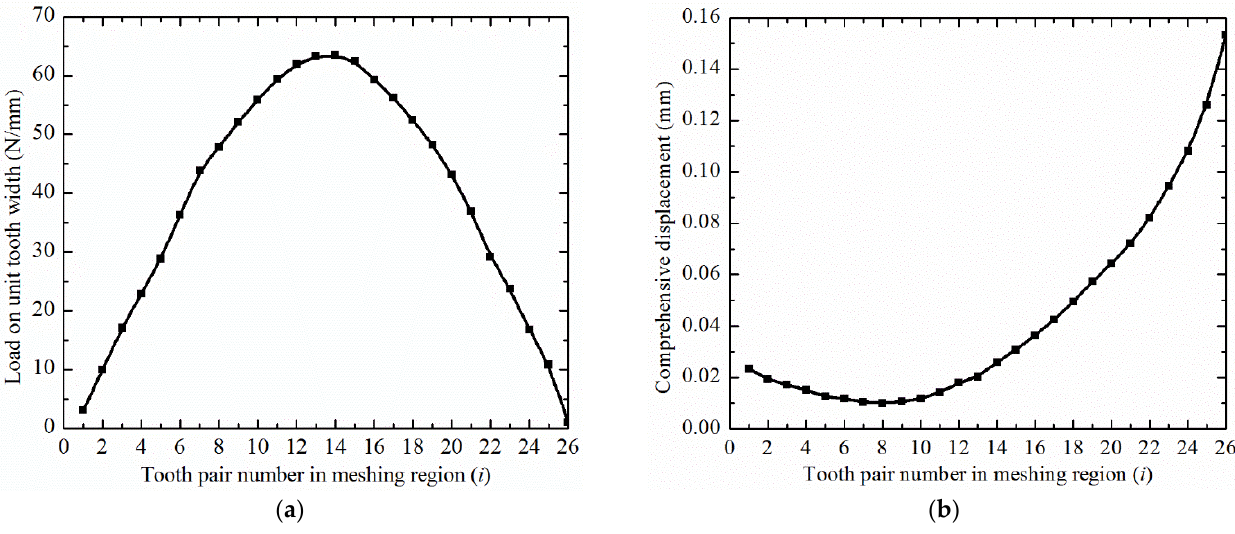
Figure 22. ( a ) Load on the width of the unit tooth of each node in the meshing region; ( b ) comprehensive displacement of each node in the meshing region.